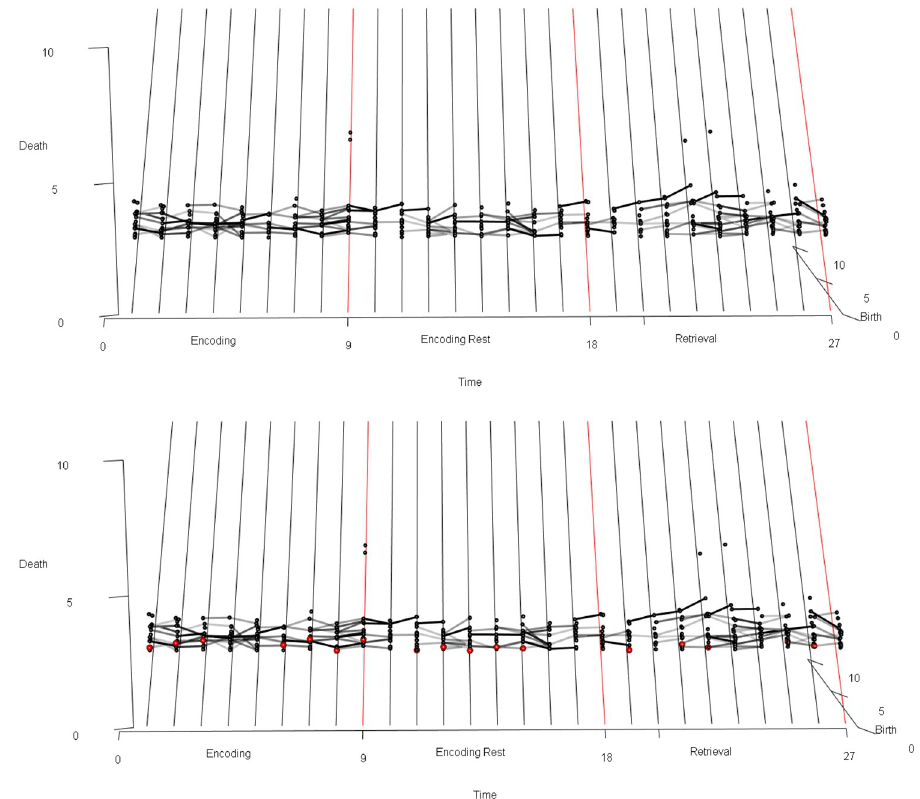
Fig 12. The 27 time indices of the vineyard from Fig 9, from a different perspective. The red dots are members of a statistically identified vine which is intermittent, i.e., not present at every time index. This intermittently-present topological structure forms a “vine” in the sense that it remains within a tightly constrained region of stereotactic space in the ACC. The persistence of this vine at each time index where it is present is correlated with whether that time index is part of the memory encoding epoch of the experimental task. In particular, the vine is statistically significantly more persistent in encoding epochs than in retrieval epochs.